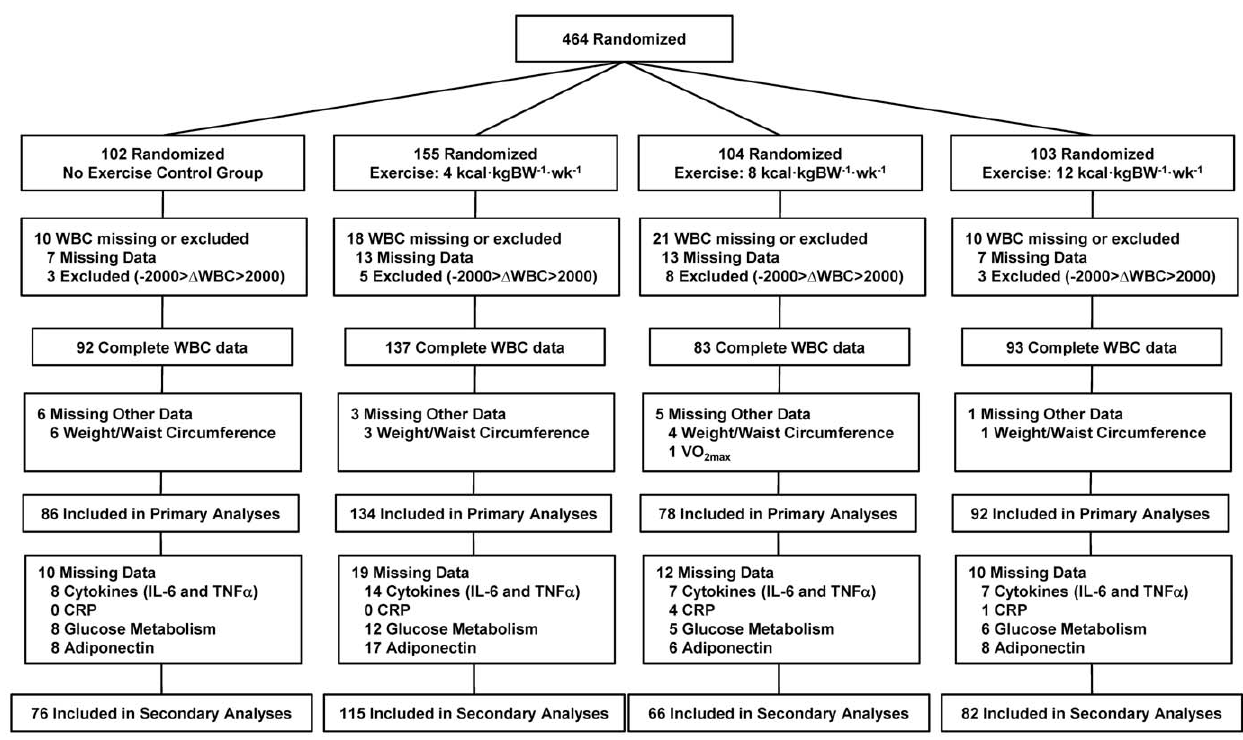
Figure 1. CONSORT schematic of study participation.